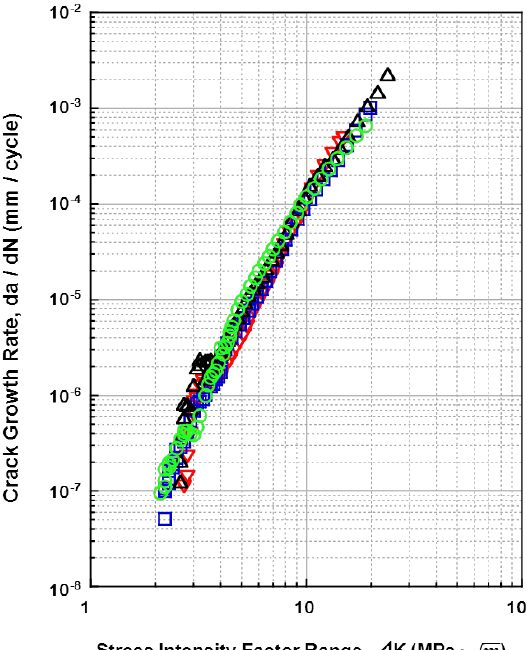
Figure 17. Effect of 0.9% NaCl on fatigue crack growth rate obtained by fatigue crack test of annealed Ti-15Zr-4Nb-4Ta alloy.